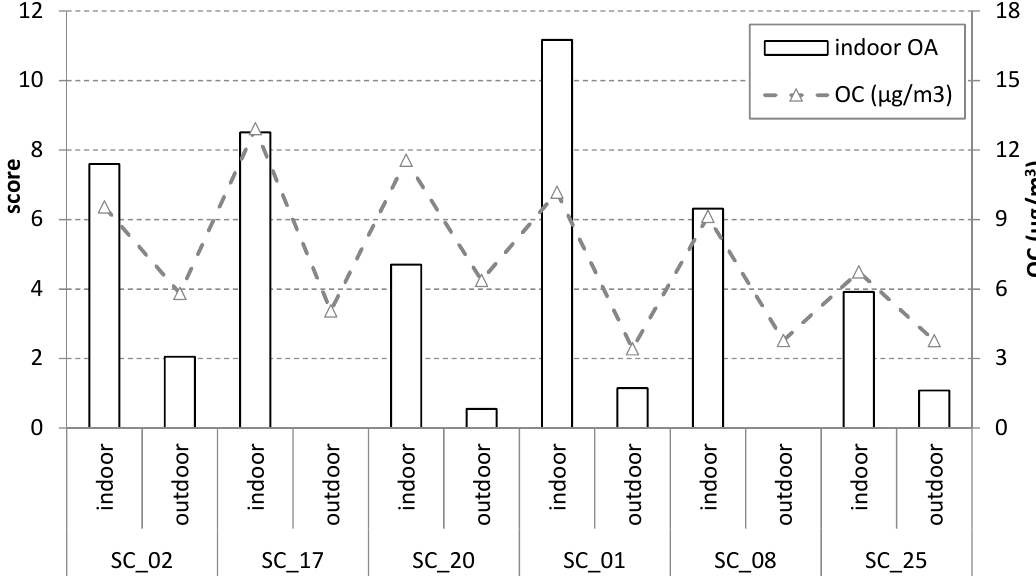
Figure 5. Scores values of the two components, interpreted as outdoor and indoor organic aerosol (left y -axis), obtained by positive matrix factorization of the concentrations of organic molecular tracers of the selected schools. The average OC concentration in the schools (right y -axis, µg/m 3 ) is also displayed. The locations of the stations are shown in Figure 1.